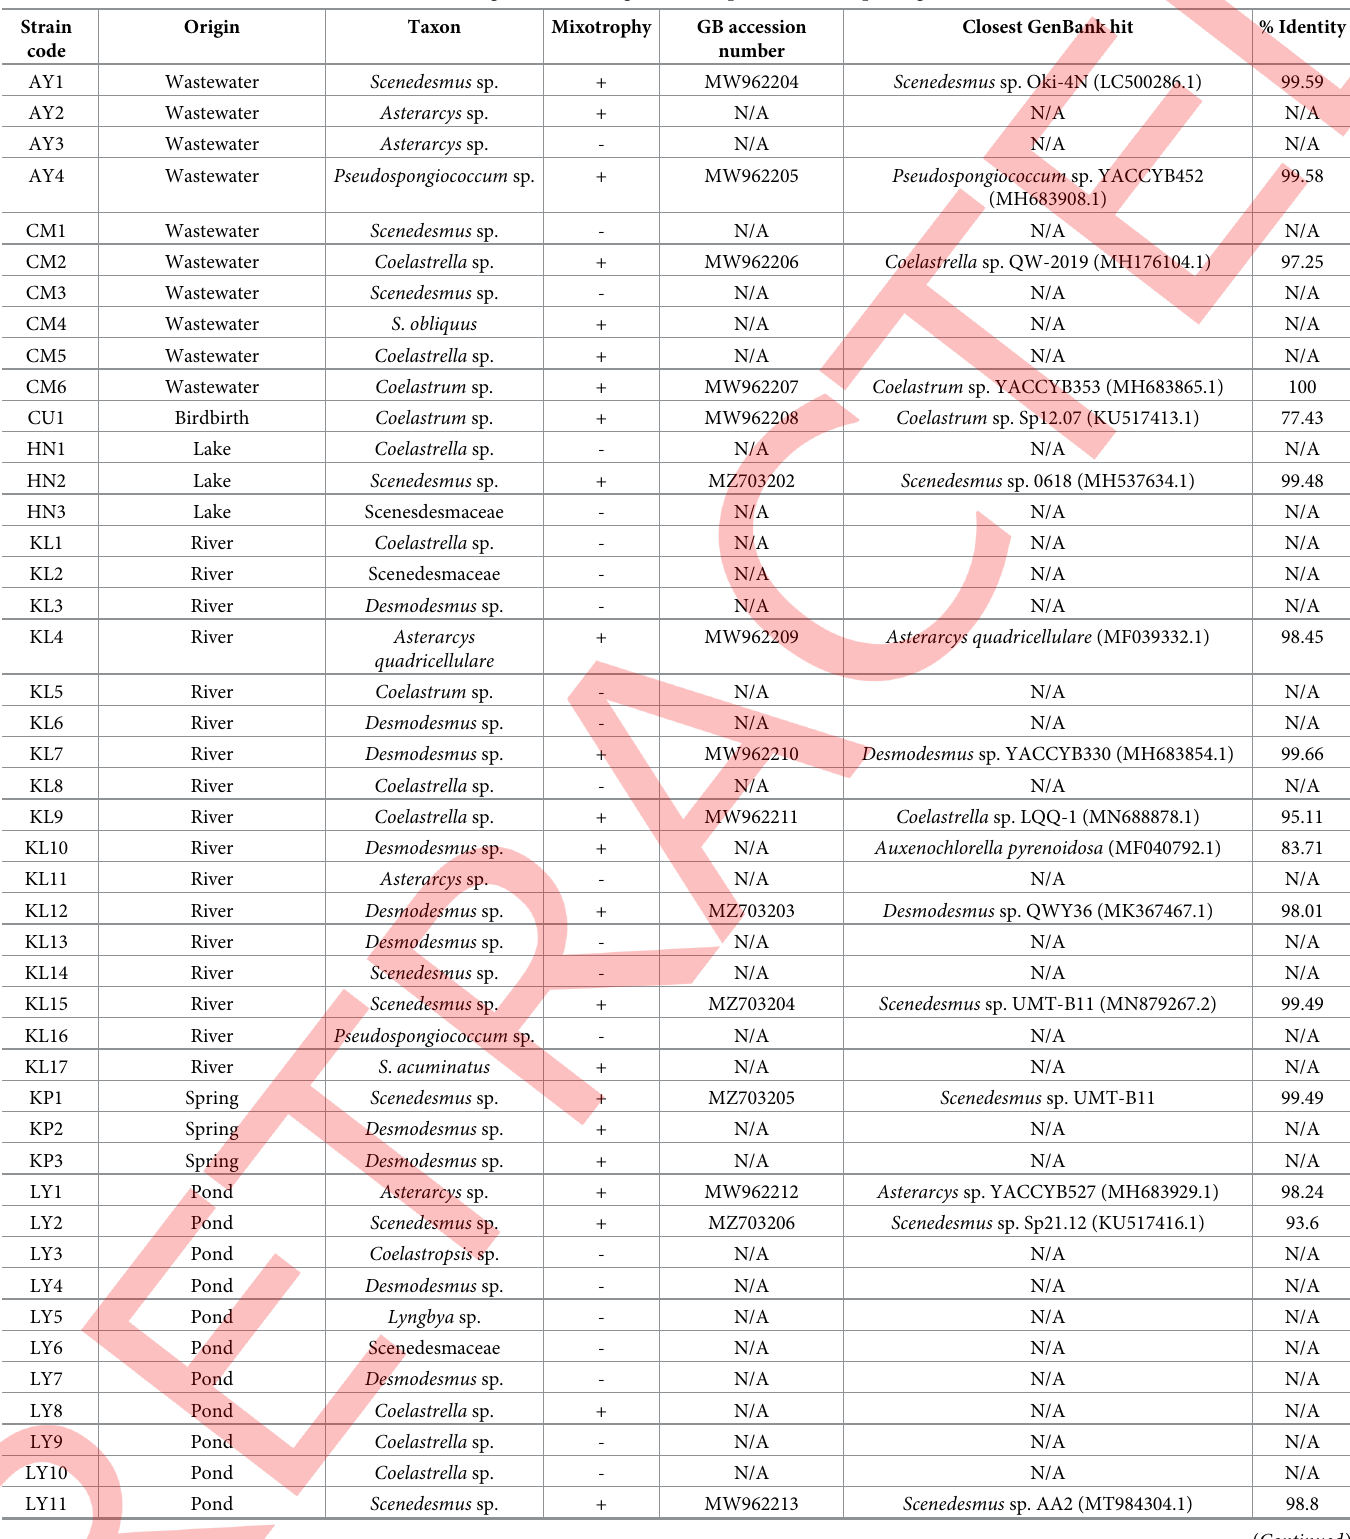
Table 1. Characterization and identification of the microalgae strains, along with description of the sample origin. Strain